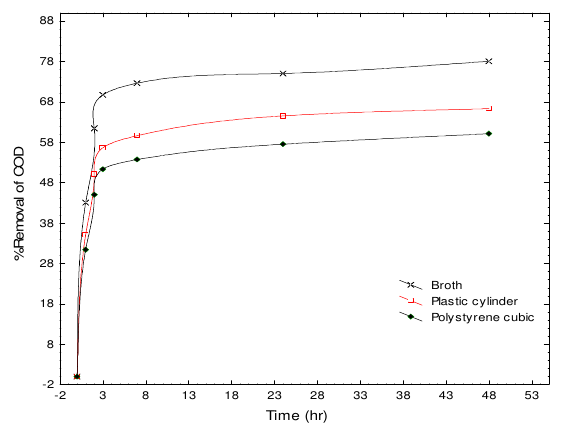
Fig. 19. Effect of Packing type on the Removal per cent of NO 3 pollutant with time at T=25 o C, pH 7, and sterilized wastewater.